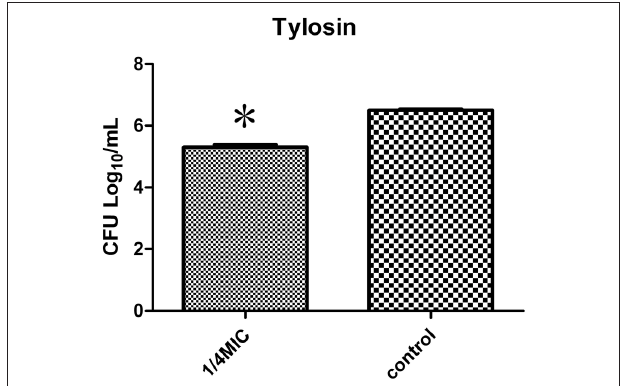
FIGURE 3 | Effect of 1/4 MIC of tylosin on S. suis ATCC 700794 biofilm formation by colony forming unit (CFU) enumeration. The data are expressed as the means ± standard deviations. Significant decrease ( * p < 0.05) compared with control biofilm formation of S. suis in vitro